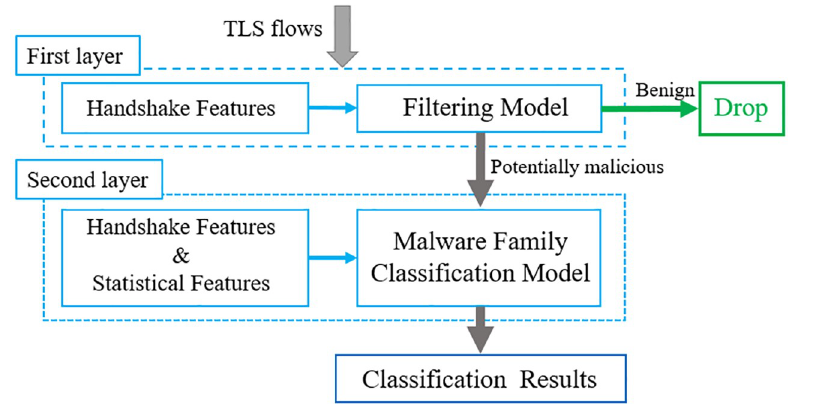
Fig 1. Two-layer detection